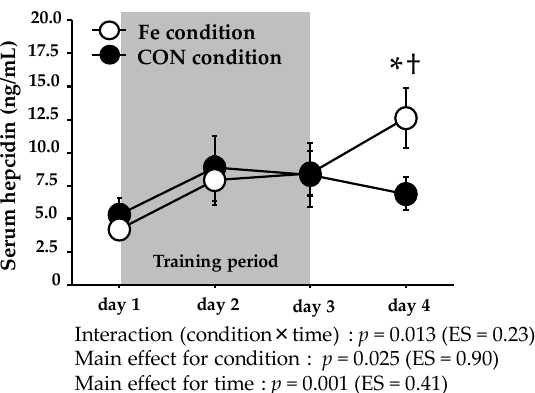
Figure 3. Serum hepcidin levels during days 1–4. The values are means ± SE. * Significant difference from day 1. † Significant difference between conditions.